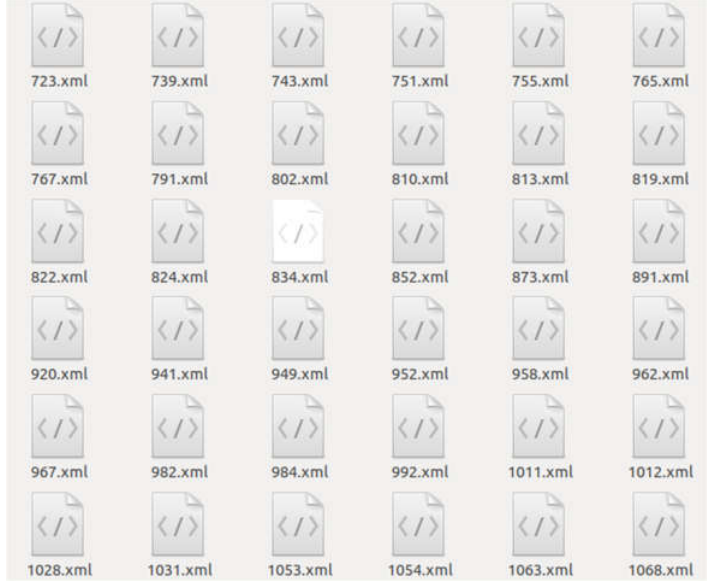
Figure 11. Sample dataset image.